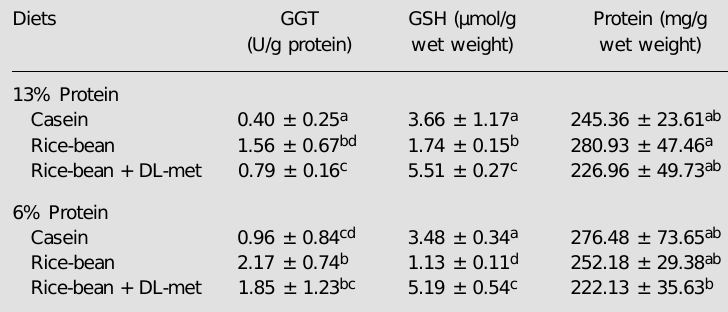
Table 2 - Effect of protein restriction on GGT activity, GSH concentration and protein concentration in the liver of rats during growth (22-50 days of age). Data are reported as means ± SD (N = 5-18). In any one column, the values of the means marked with different superscripts are significantly different (P<0.05, ANOVA test for two groups). U = µmol of p-nitroaniline released/min, at 37 o C; DL-met = DL-